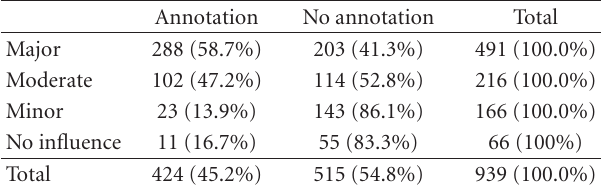
Table 4: Rate of annotations in the medical records about the out- come of chest radiography of 939 examinations, grouped according to influence of the chest radiography outcome on treatment. Cases with higher influence on treatment were to a higher degree remarked on in the medical